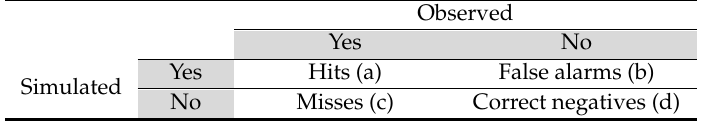
Table 3. The conditions of the di ff erent cloud cases for model simulation and